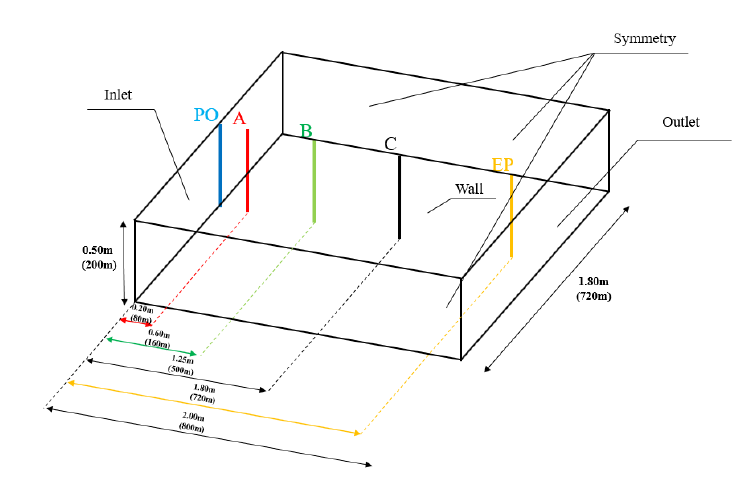
Figure 5. Computational